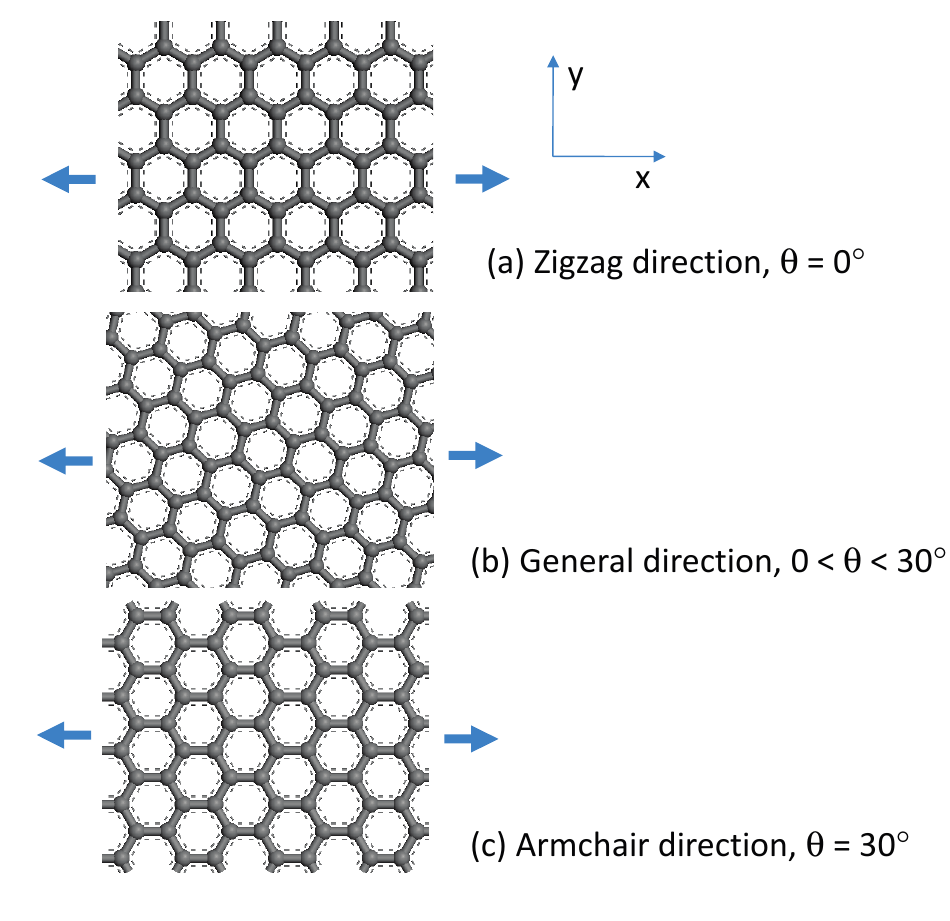
Figure 1. Monolayer graphene under in-plane tension along the different chirality angles: ( a ) Zigzag direction, θ = 0 ° ; ( b ) General direction, 0 ° < θ < 30 ° ; ( c ) Armchair direction, θ = 30 ° . The periodic boundary condition is applied on both x and y